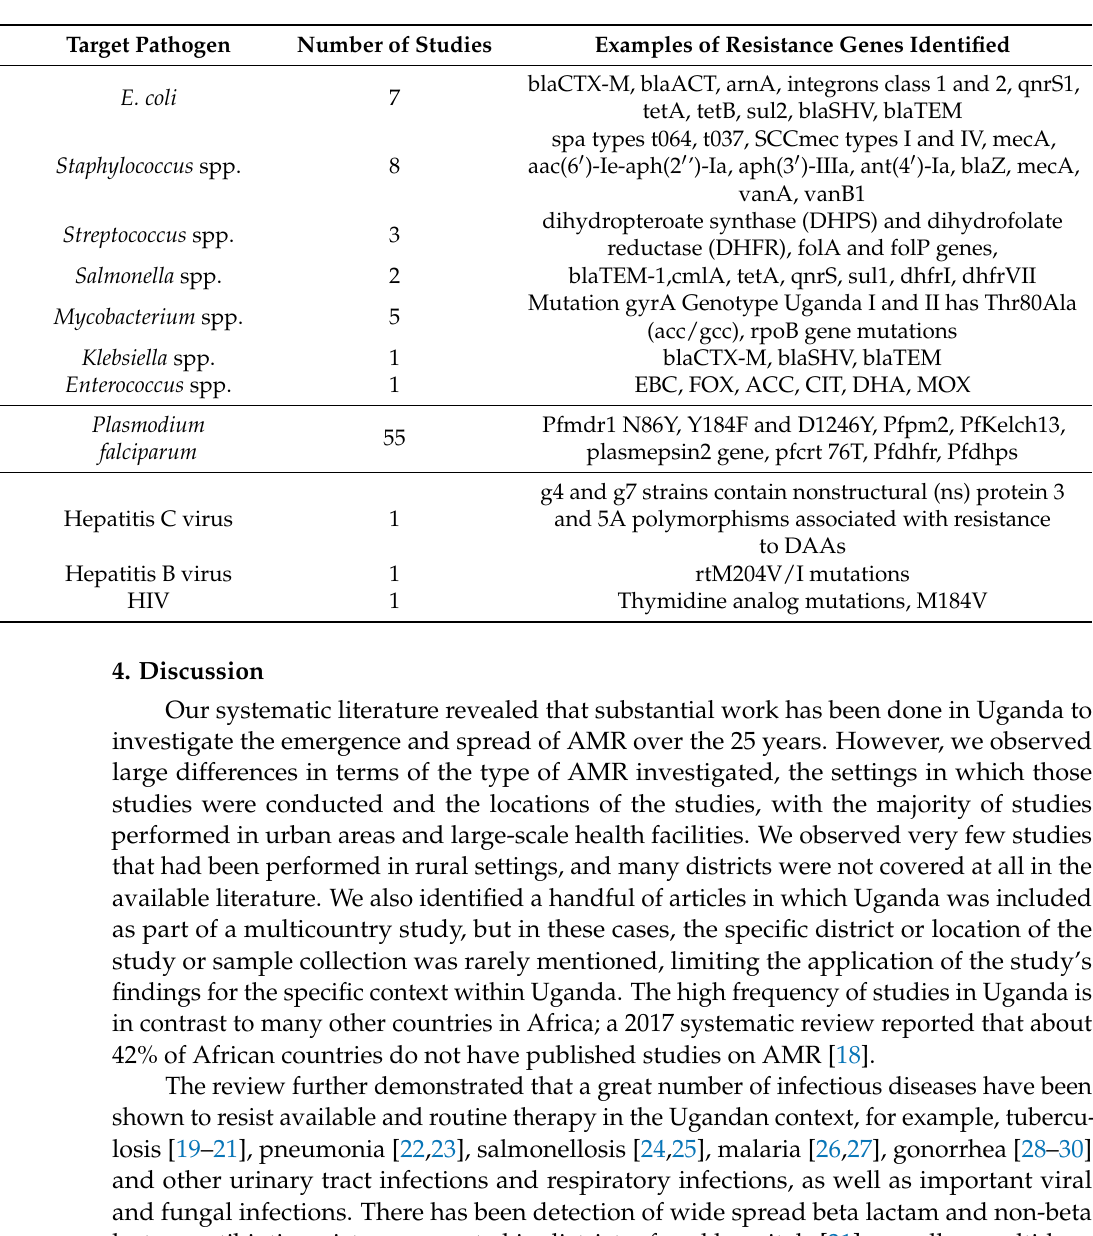
Table 2. Resistance Genes Identified in the Included